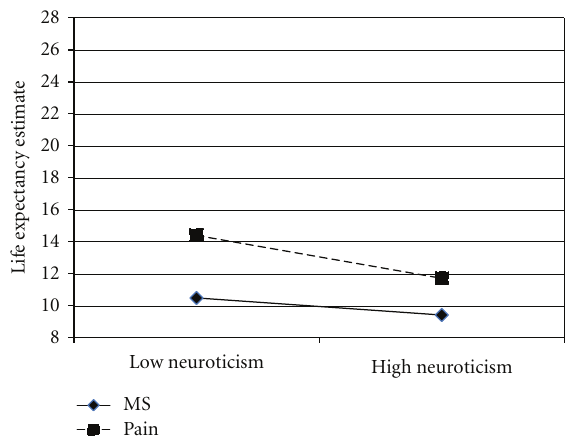
Figure 1: Life expectancy estimates as a function of mortality salience and neuroticism among old-old adults. Note that scores indicate estimated remaining years to